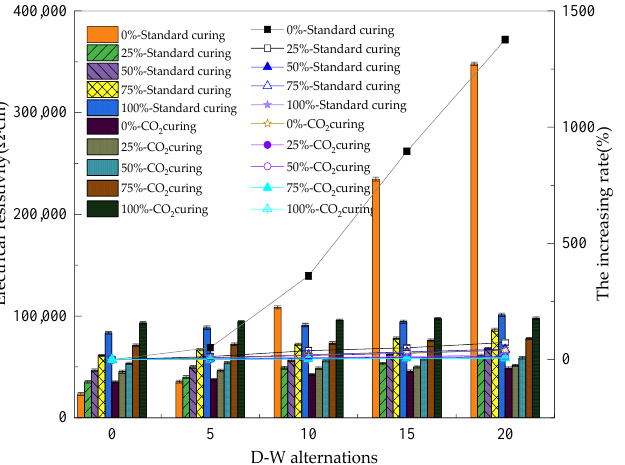
Figure 6. The electrical resistivity of reinforced alkali-activated mineral admixtures during D – W